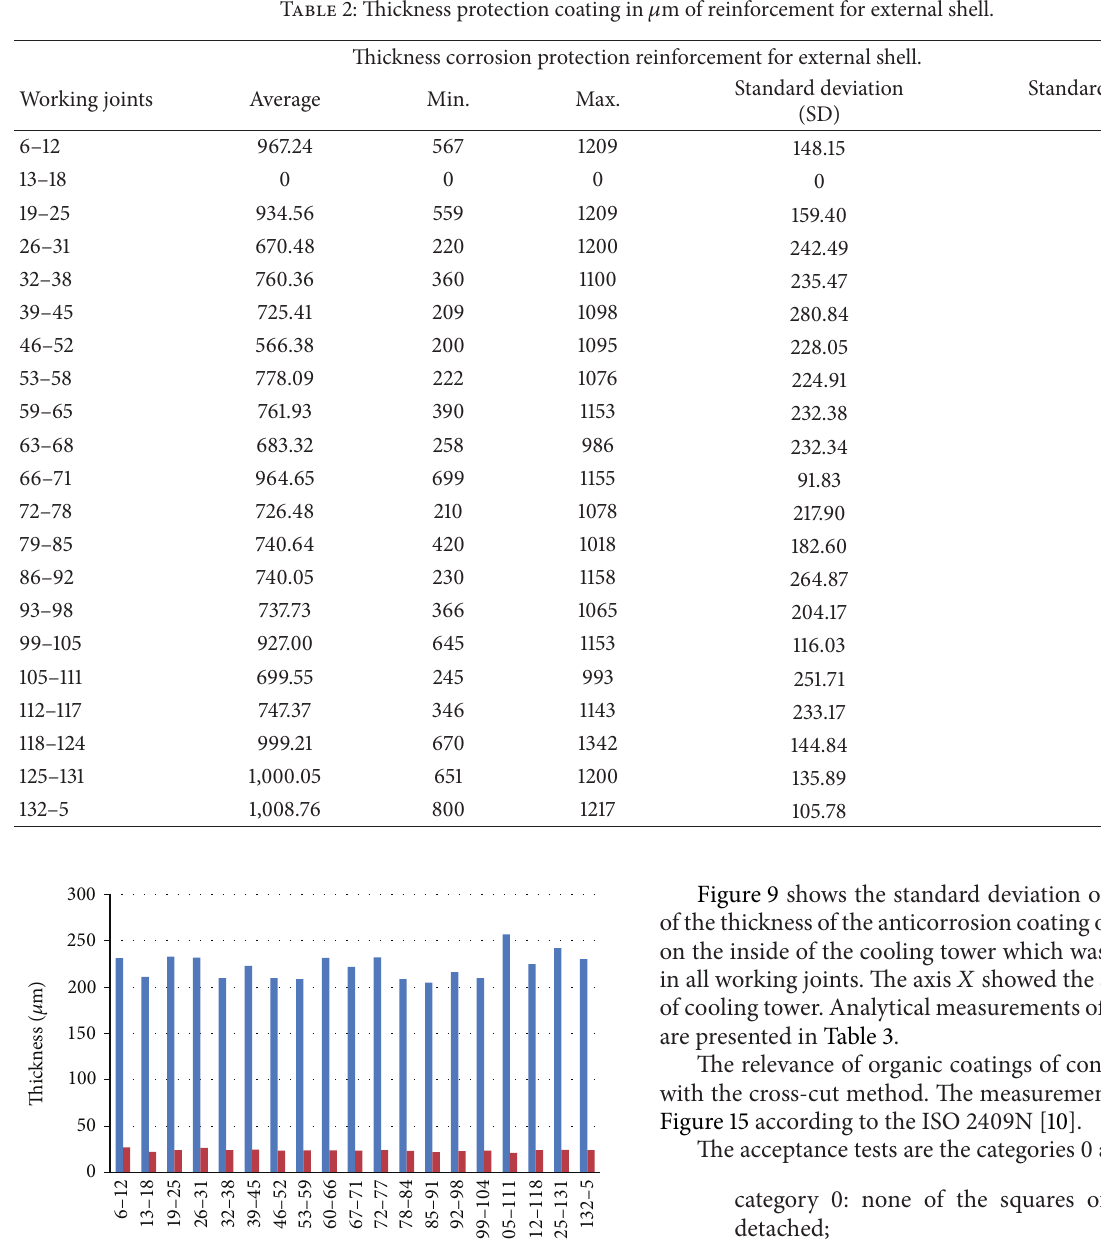
category 0: none of the squares of the panel are detached; category 1: detachment of small flakes of coating on the prices of the lines affected an area of the panel not more than